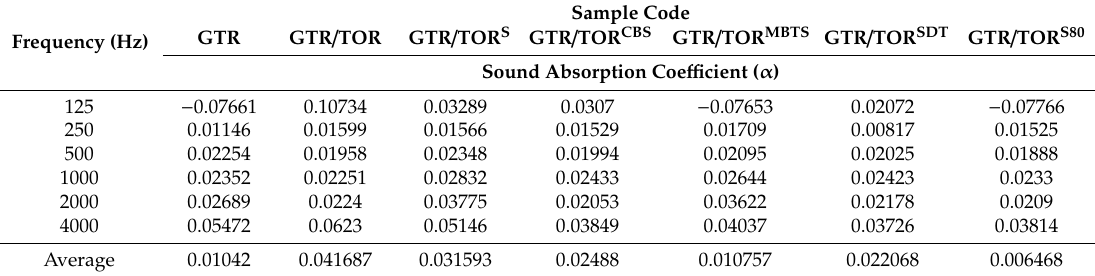
Table 7. The changes in the sound absorption coe ffi cient for the studied samples at 125, 250, 500, 1000, 2000, and 4000